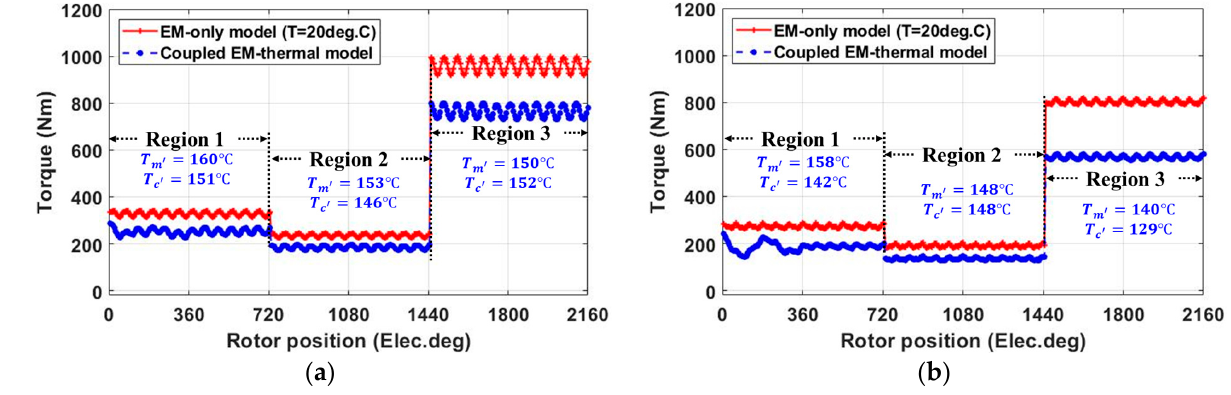
Figure 19. On-load torque vs. rotor position for ( a ) modular and ( b ) non-modular machines with and without considering EM-thermal coupling. T m ′ and Tc ′ denote the average steady state magnet and coil temperatures obtained by the coupled EM-thermal model.